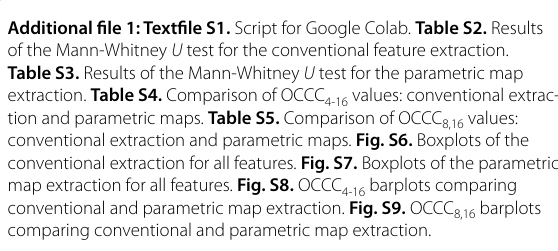
Table S3. Results of the Mann‑Whitney U test for the parametric map extraction. Table S4. Comparison of OCCC 4‑16 values: conventional extrac‑ tion and parametric maps. Table S5. Comparison of OCCC 8,16 values: conventional extraction and parametric maps. Fig. S6. Boxplots of the conventional extraction for all features. Fig. S7. Boxplots of the parametric map extraction for all features. Fig. S8. OCCC 4‑16 barplots comparing conventional and parametric map extraction. Fig. S9. OCCC 8,16 barplots comparing conventional and parametric map